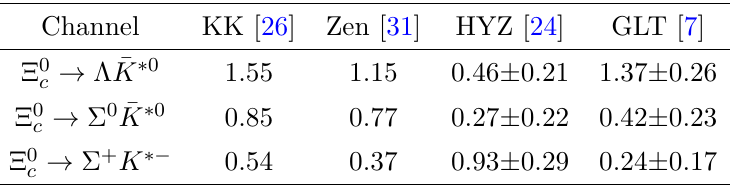
Table 1 . Decay branching fractions (%) of the Cabibbo-favored Ξ 0 covariant quark model from KK [26], pole model from Zen [31], and SU(3) F flavor symmetry from HYZ [24] and GLT [7].